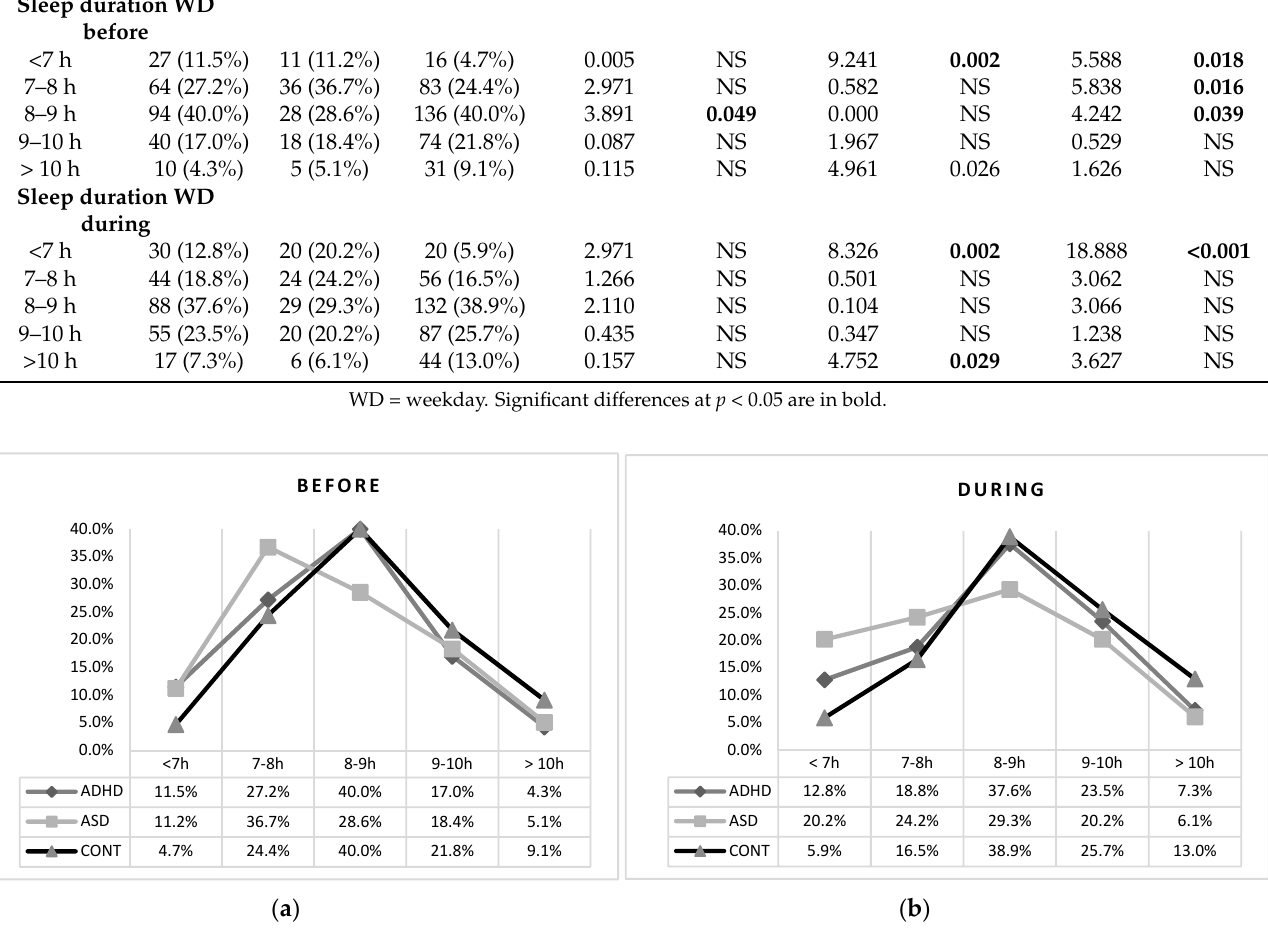
ADHD children showed a higher percentage of delaying and a lower percentage of maintaining weekday bedtime than ASD and controls and tended to delay risetime during weekday and weekend more than ASD but not than controls (Table 5). Sleep duration changes were not different between the ADHD and ASD groups, while controls showed a higher percentage of children who maintained the same sleep duration. Compared to controls, both clinical groups increased the weekday and weekend sleep latency during the lockdown (Table 6). Table 5. Comparison of weekday–weekend bedtime and risetime in the three groups. Delayed